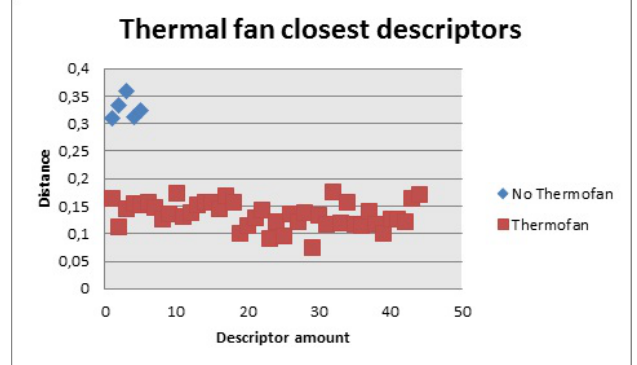
Figure 25. Closest descriptors with and without thermal